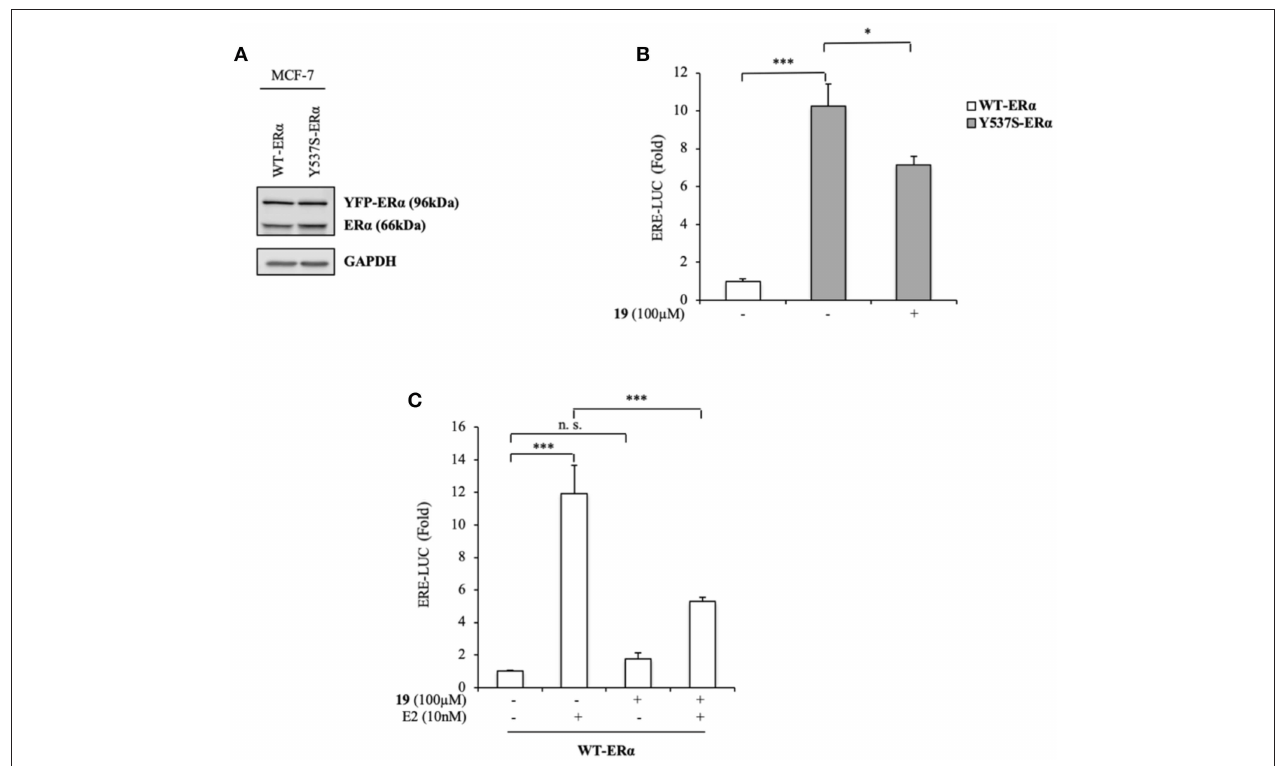
FIGURE 4 | Effects of compound 19 on WT and Y537S ER α activation in MCF-7 breast cancer cells. (A) Immunoblotting showing exogenous and endogenous ER α protein expression in ER α -positive MCF-7 breast cancer cells transiently transfected with YFP-WT or YFP-Y537S ER α expressing vectors. GAPDH was used as a control for equal loading and transfer. (B) ER α -transactivation assay in MCF-7 cells transiently transfected with YFP-WT or YFP-Y537S ER α expressing vectors plus an ERE-luciferase reporter (XETL), and treated with vehicle (-) or the compound 19 at 100 µ M, as indicated. Data are reported as fold change relative to WT-ER α expressing cells. (C) ER α -transactivation assay in MCF-7 cells transiently transfected with YFP-WT plus XETL plasmid, and treated with vehicle (-) or the compound 19 (100 µ M) in the presence or not of 17 β -estradiol (E2, 10nM). Data are reported as fold change relative to vehicle (-)-treated cells. The values represent the mean ± S. D. of three different experiments, each performed in triplicate. n. s., non-significant; * P < 0.05; *** P < 0.0005.